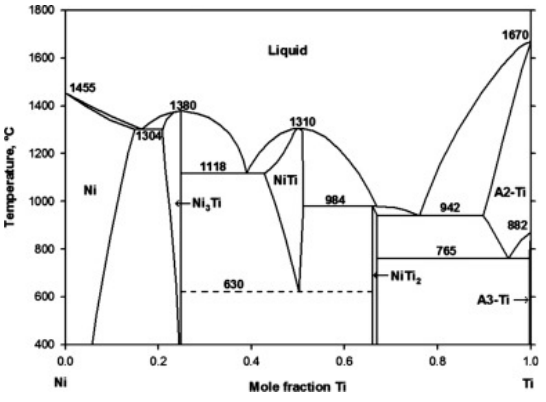
Figure 1. Binary diagram of Ni–Ti data from [2].